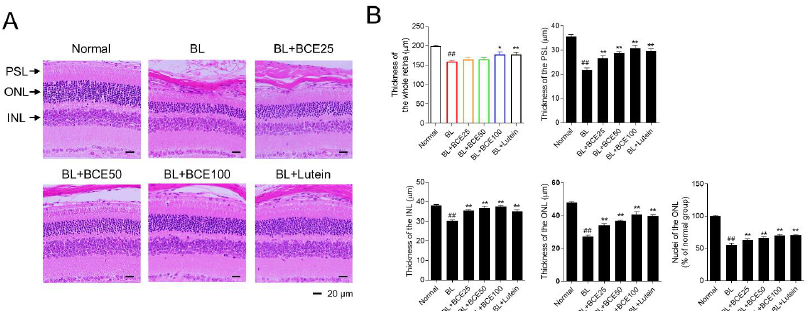
Figure 4. Protective effects of BCE on BL-induced retinal degeneration. ( A ) H&E staining for the evaluation of histological changes. Sections between 100 and 200 μm from the optic nerve of both eyes were observed. ( B ) Measurement of the whole retina, photoreceptor segment layer (PSL), outer nuclear layer (ONL), inner nuclear layer (INL) thickness, and number of nuclei in ONL. The results are presented as the mean ± standard error of the means ( n = 10). ## p < 0.01 vs. normal group, * p < 0.05, ** p < 0.01 vs. BL group.